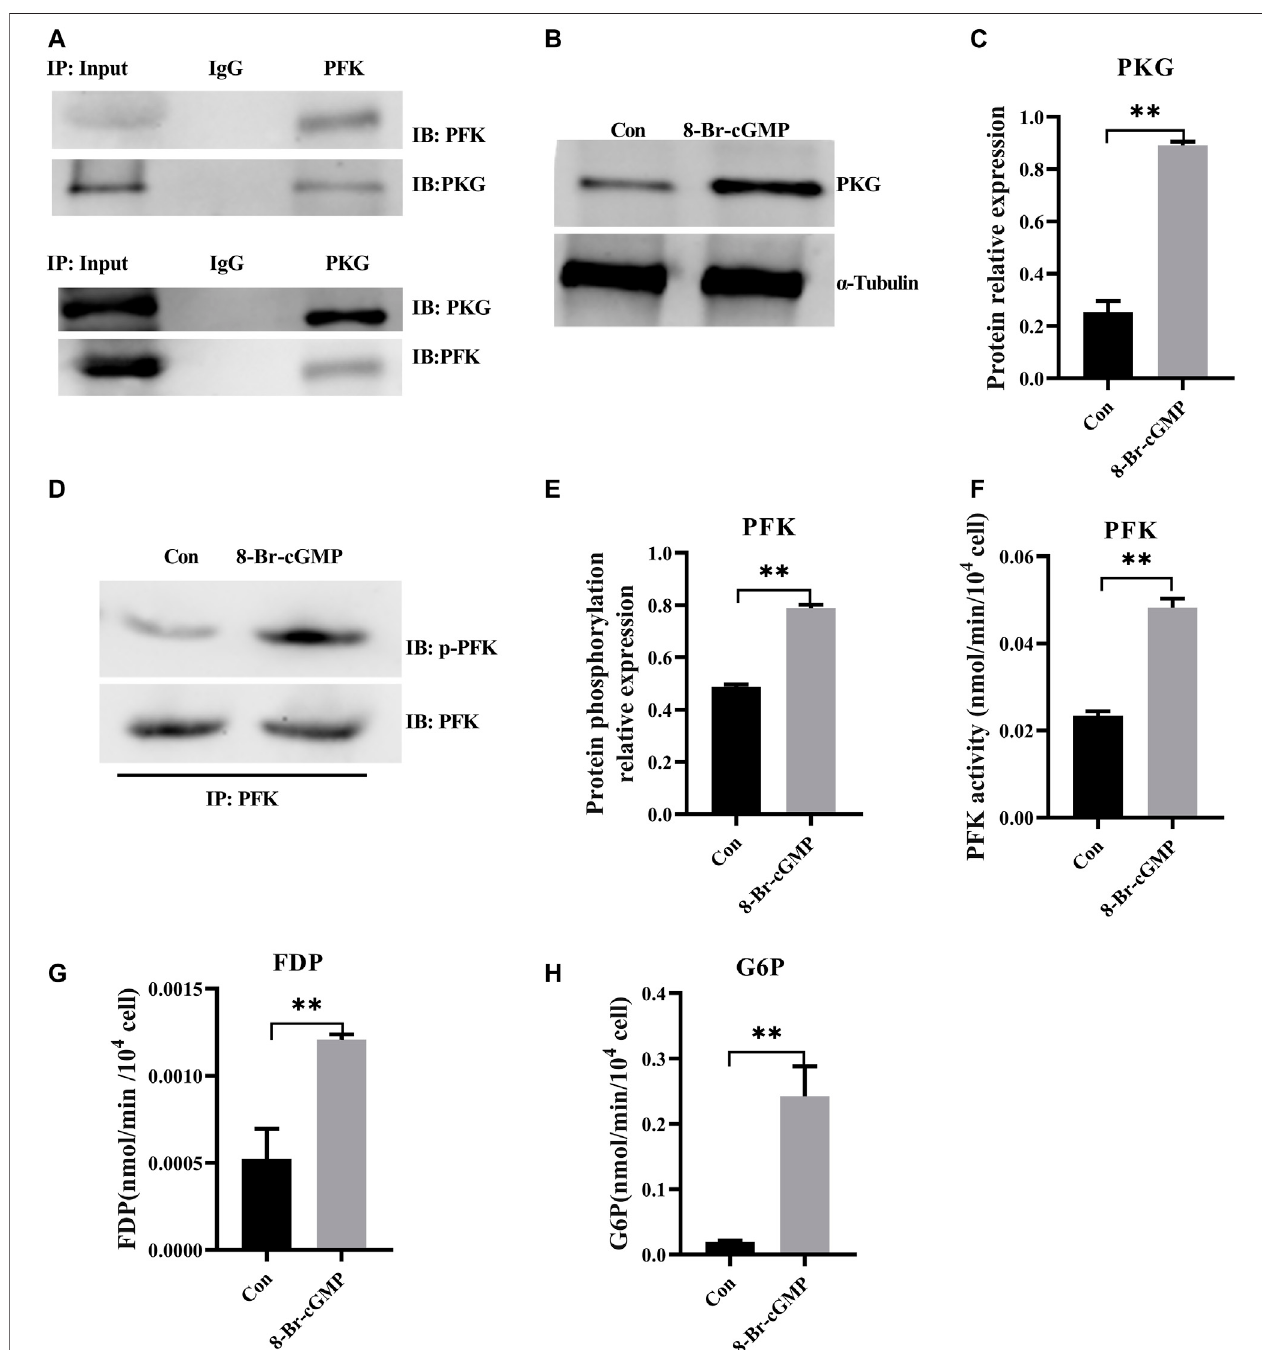
FIGURE 5 | Activation of cGMP-PKG promotes glycolysis via increasing phosphorylation of PFK. (A) PKG interacts with PFK by co-immunoprecipitation and immunoblottinganalysesincattleheart. (B,C) Theexpression ofPKGat theproteinlevelafter theactivationof8-Br-cGMP intheH9C2 cells. (D,E) Phosphorylationlevel of PFK protein by immunoprecipitation after the activation of 8-Br-cGMP in the H9C2 cells. (F) Activity for PFK enzymes after the activation of 8-Br-cGMP in the H9C2 cells. (G,H) Content for key metabolites in glycolysis pathway after the 8-Br-cGMP treatment. FDP, Fructose-1,6 diphosphate; G6P, Glucose-6-phosphate. All data are presented as mean ± SD. Compared with the control group, * p < 0.05, ** p < 0.01, ns: no signi fi cant; t -tests were used to calculate the p -values.